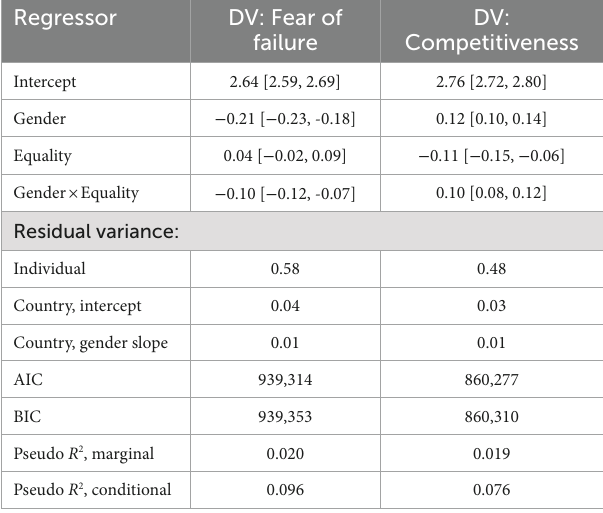
TABLE 3 Results of mixed-level analyses of fear of failure and